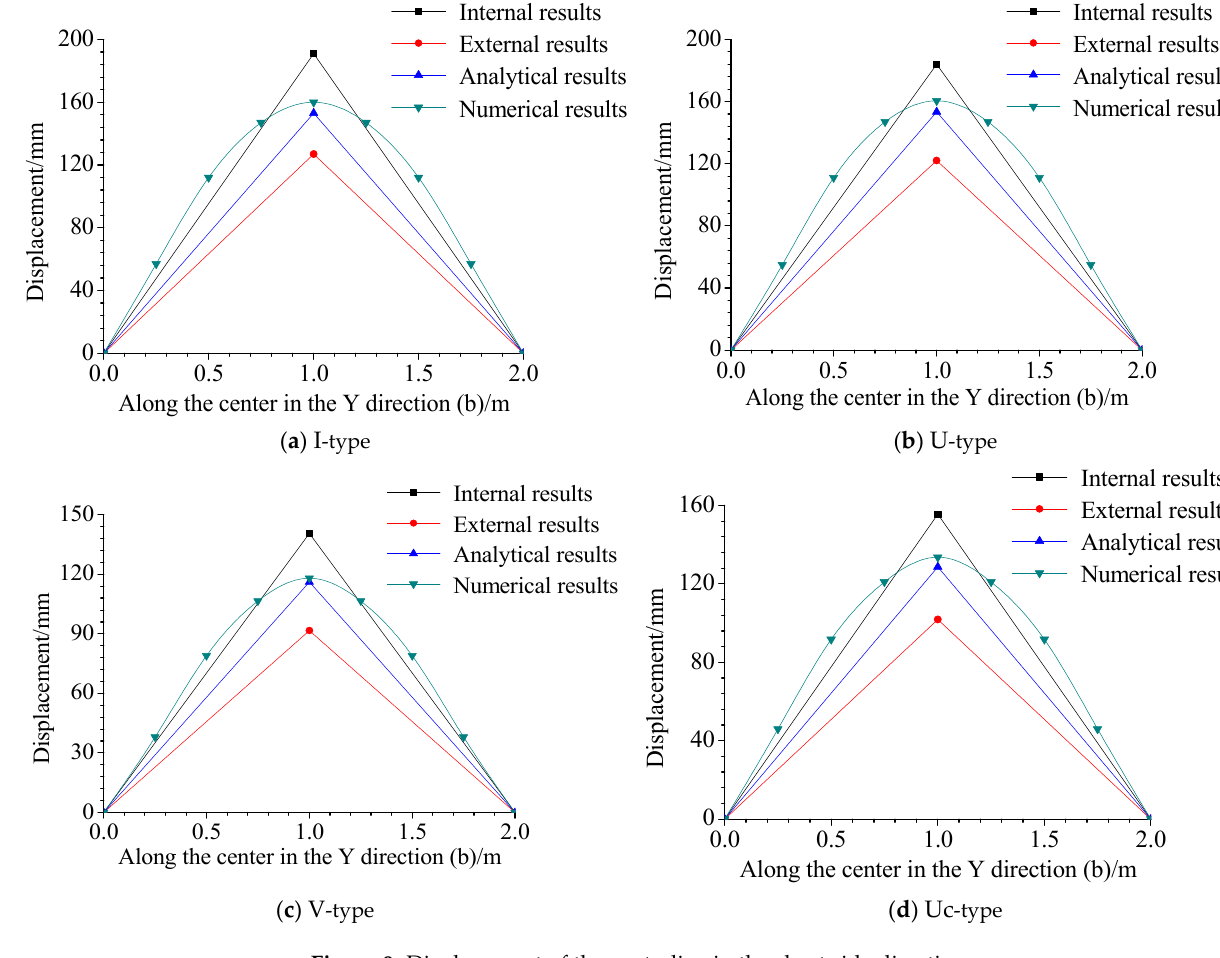
Figure 9. Displacement of the centerline in the short side direction.